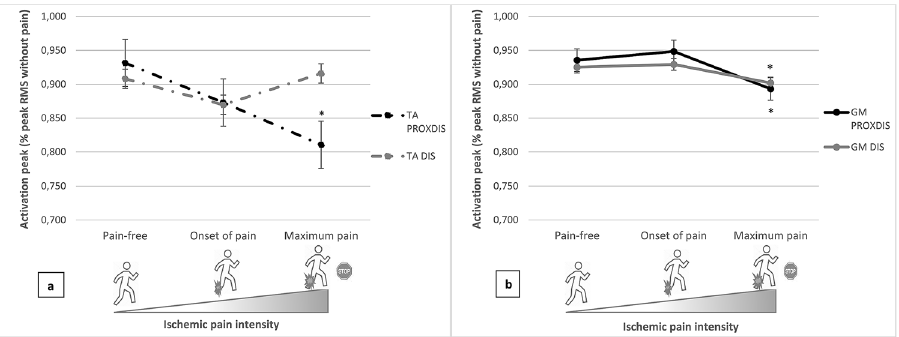
Figure 2. Activation peak of tibialis anterior (TA) ( a ) and gastrocnemius medialis (GM) ( b ) according to ischemic pain intensity and location of ischemia as a percentage of the peak Root Mean Square (RMS) during the Pain-free phase in the ischemic leg. Values are mean and standard deviation. * P < 0.05 between “Pain-free” and “Maximum pain” phases with a Kruskall Wallis test.